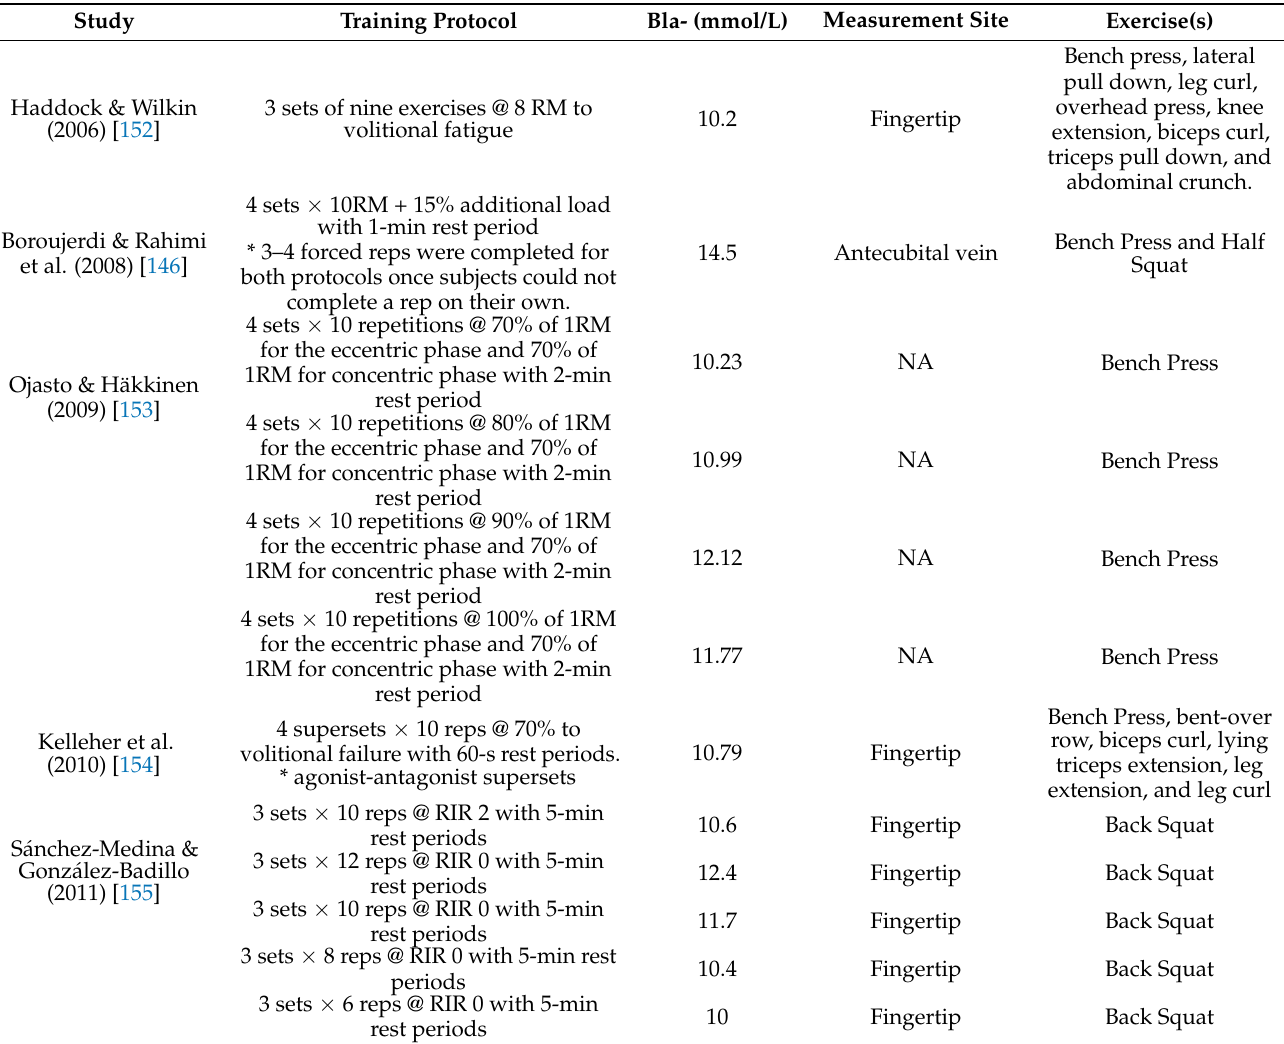
Table 2. Blood Lactate Responses to Various Resistance Training